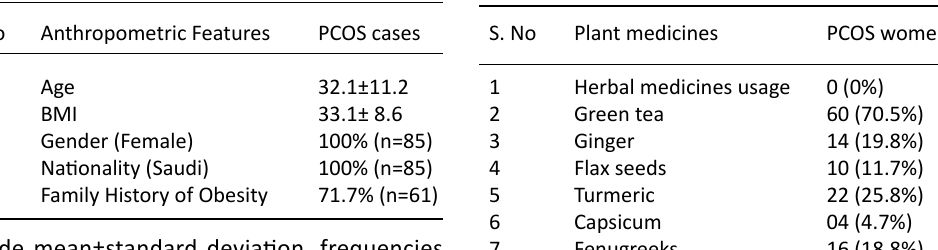
Table 2. Herbal medicine used for obesity